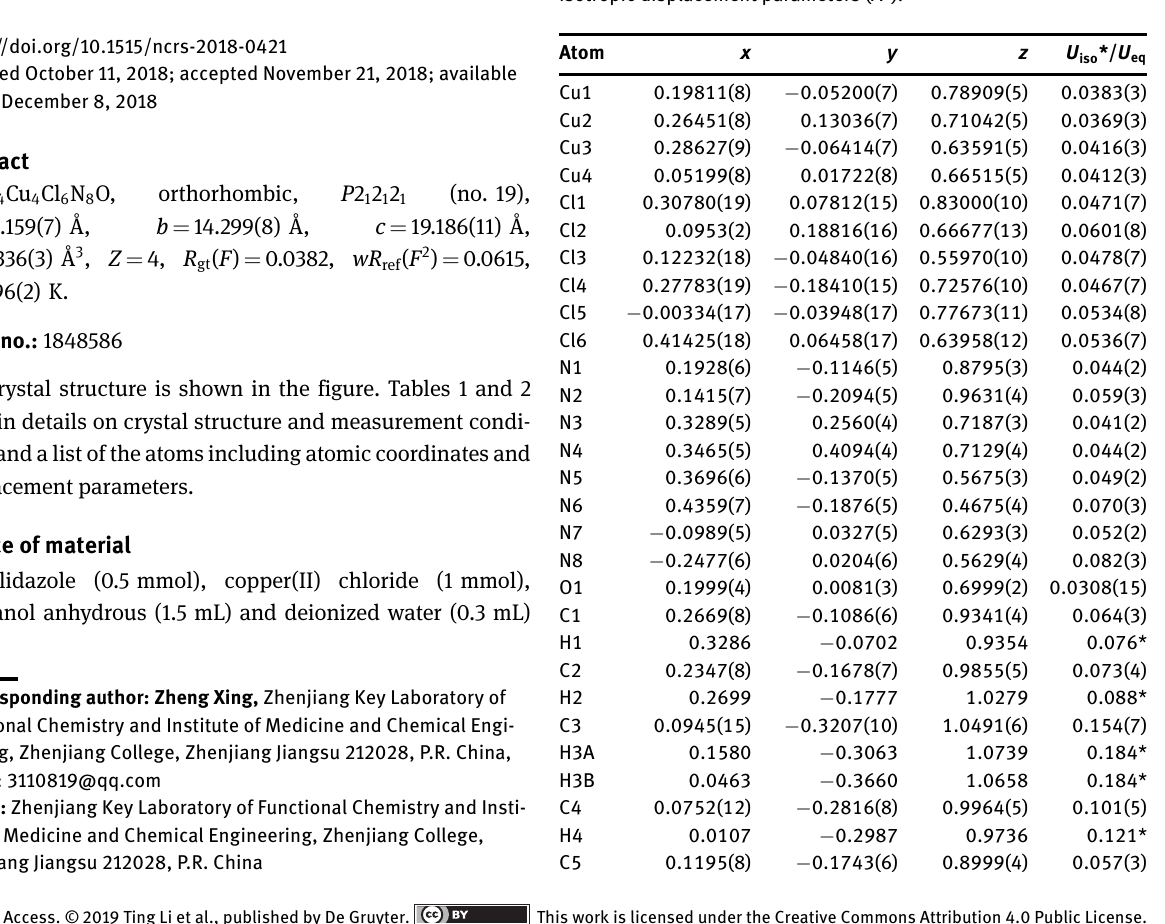
Table 2: Fractional atomic coordinates and isotropic or equivalent isotropic displacement parameters (Å 2